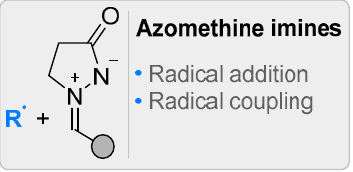
Figure 4. Radical-based transformations of azomethine imines.